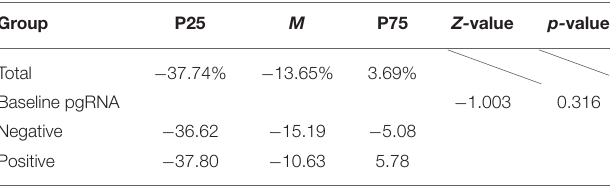
TABLE 5 | Description and difference analysis of HBsAg change magnitude between different baseline pgRNA groups.